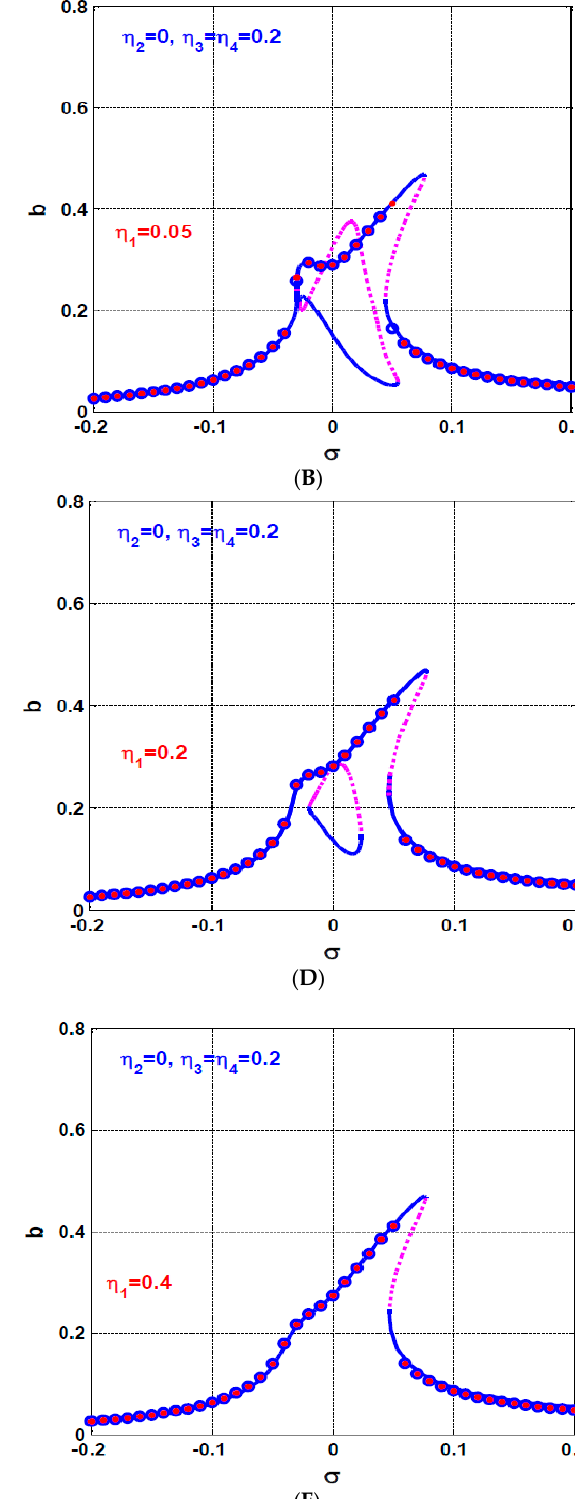
( F ) Figure 6. The rotor system steady-state time-response according to Figure 5A,B when 𝜎 = 0 : ( A , B ) temporal oscillation in 𝑋 and 𝑌 directions, respectively, ( D , E ) temporal oscillations of the U-IRC and V-IRC, respectively, ( C , F ) the corresponding periodic orbits.